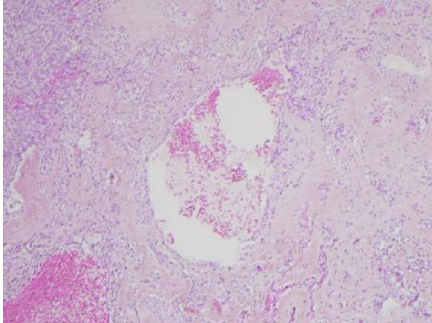
Figure 4: Areas with extensive sheet-like reactive bone deposition in subperiosteal ABC (H&E, 4x).